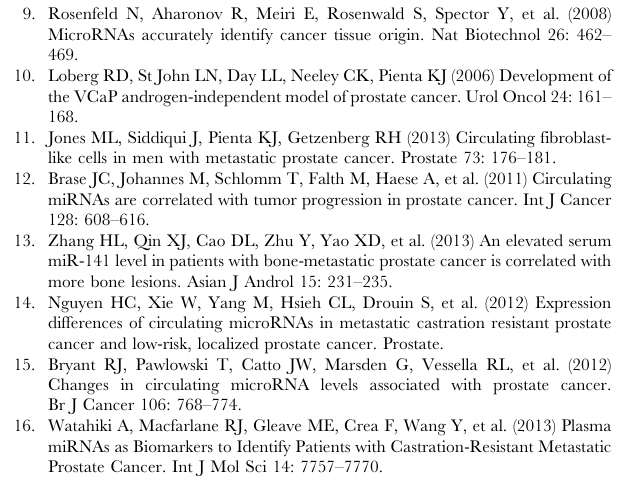
Table S1 Validation of candidate microRNA biomark- ers in serum from mCRPC patients and healthy controls by single-plex microRNA TaqMan qRT-PCR. Table S2 Correlation analysis of mCRPC-associated serum miRNAs with each other and with serum PSA. Table S3 Results of measurement of mCRPC-associat- ed serum microRNA markers and endogenous controls in microdissected laser-captured primary prostate cancer (‘‘Cancer’’) and lymph node metastases (‘‘LN Met’’) tissue. Table S4 Single-plex TaqMan assays used in this